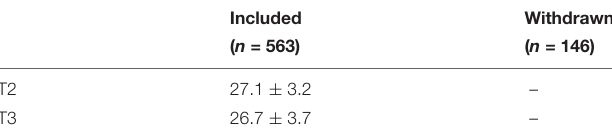
TABLE 2 | Multivariate GEE model on the association between PDS and baseline